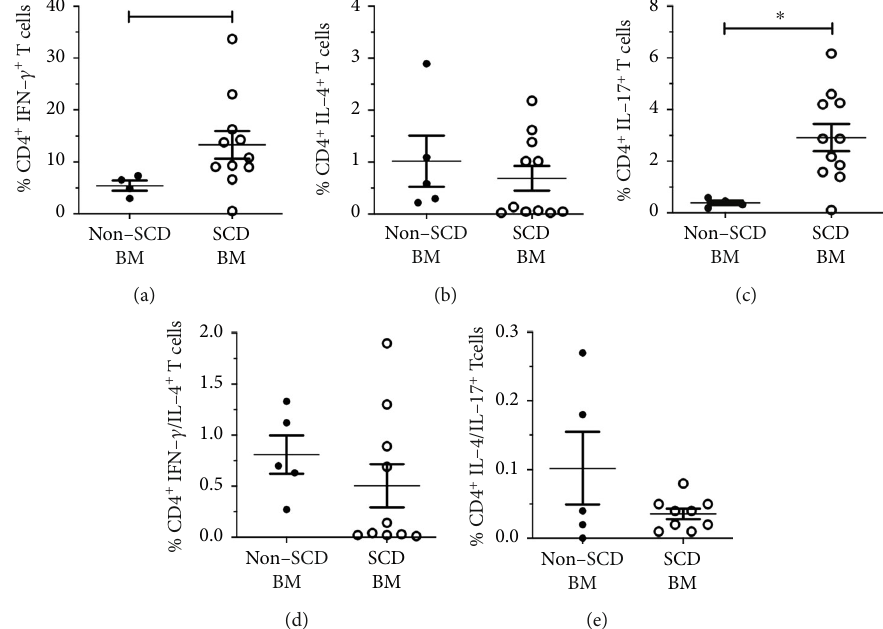
Figure 4: Increased frequency of IFN- γ + CD4 + T and IL-17 + CD4 + T cells in SCD BM compared to non-SCD BM patients. Bone marrow mononuclear cells (BM-MNC) from SCD patients with osteonecrosis (SCD BM) and patients with osteonecrosis not related to SCD (non- SCD BM) were culture stimulated with PMA/Io and stained for intracellular cytokine production. Relative frequency of IFN- γ + (a), IL-4 + (b), IL-17 + (c), bifunctional IFN- γ + /IL-4 + (d), and IL-4 + /IL-17 + TCD4 + (e) cells producing cytokines in relation to total TCD4 + cells in culture. Each symbol represents an individual subject. Horizontal lines represent mean and standard error. ∗ p < 0 : 05 , ∗∗ p < 0 : 005 , and ∗∗∗ p < 0 : 0005